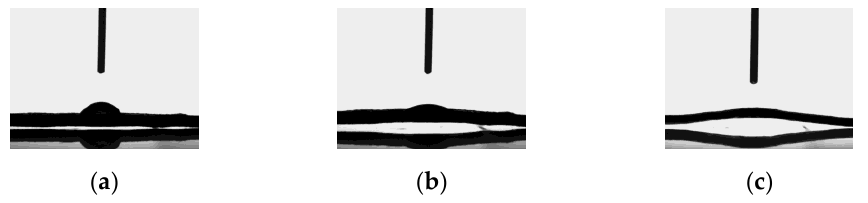
Figure 9. Contact angle of SPI films as a function of time: ( a ) t = 0 min, ( b ) t = 3 min, and ( c ) t = 5 min.